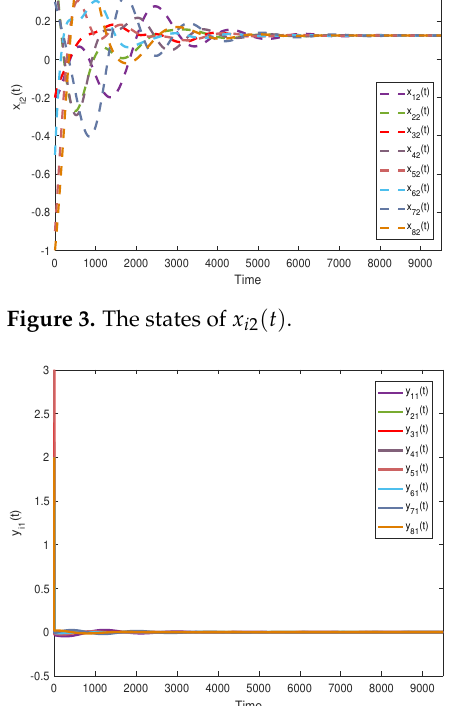
Figure 4. The trajectories of y i 1 ( t )